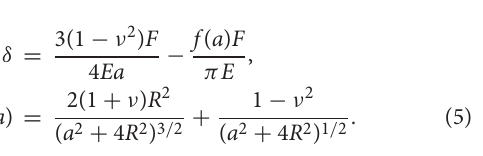
where R is the radius of the sphere, ν is Poisson’s ratio (taken as 0.49), δ is the compressive displacement, f is the force, and a is the radius of contact area. Young’s modulus can be extracted from the relationship between δ and f for values satisfying the